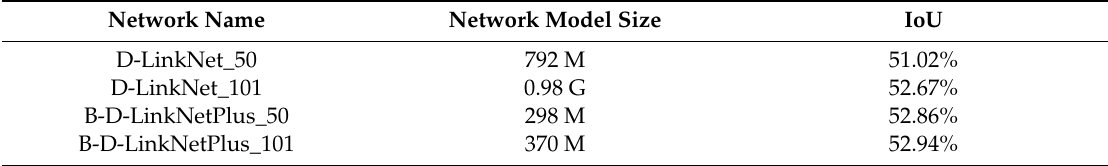
Table 3. D-LinkNet and B-D-LinkNetPlus network size and precision comparison